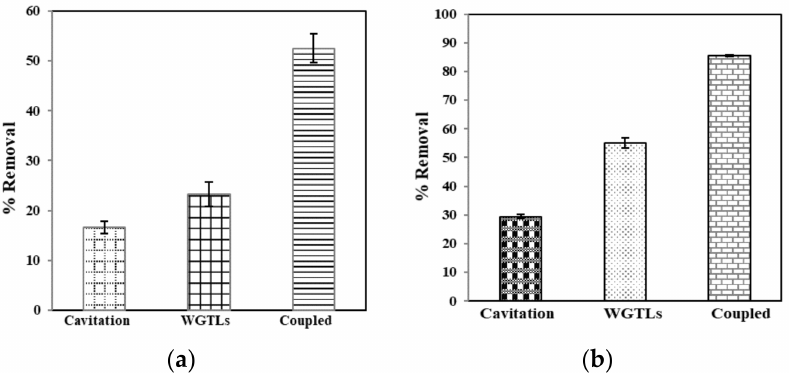
Figure 9. Removal of TOC ( a ) and COD ( b ) by cavitation, adsorption (WGTLs) and sono-adsorption (coupled)